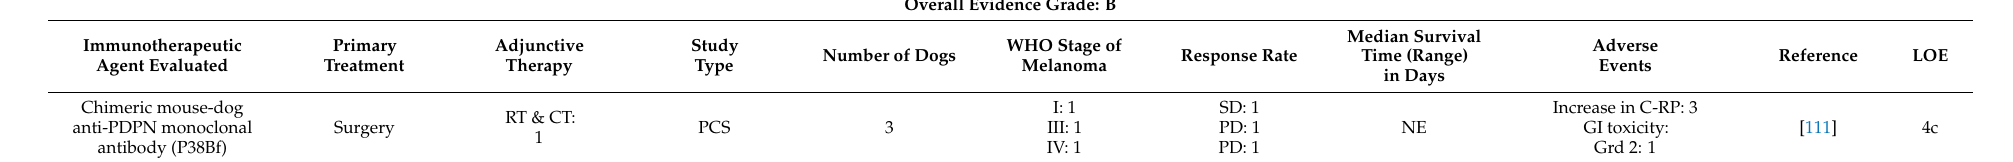
Overall Evidence Grade: B